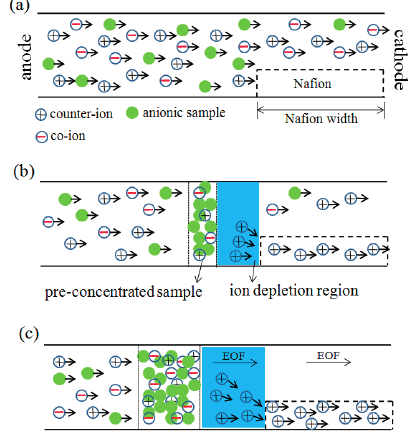
Figure3. Schematic diagram of ICP and sample accumulation with electroosmotic flow. ( a ) An external electric field is applied across the microchannel; ( b ) ICP effect occurs in which the concentration of the sample molecules gradually increases over time on the left side of the microchannel/Nafion membrane interface; ( c ) The electroosmotic flow carries electroneutral fluid after the depletion region moving above the Nafion membrane continuously to the right